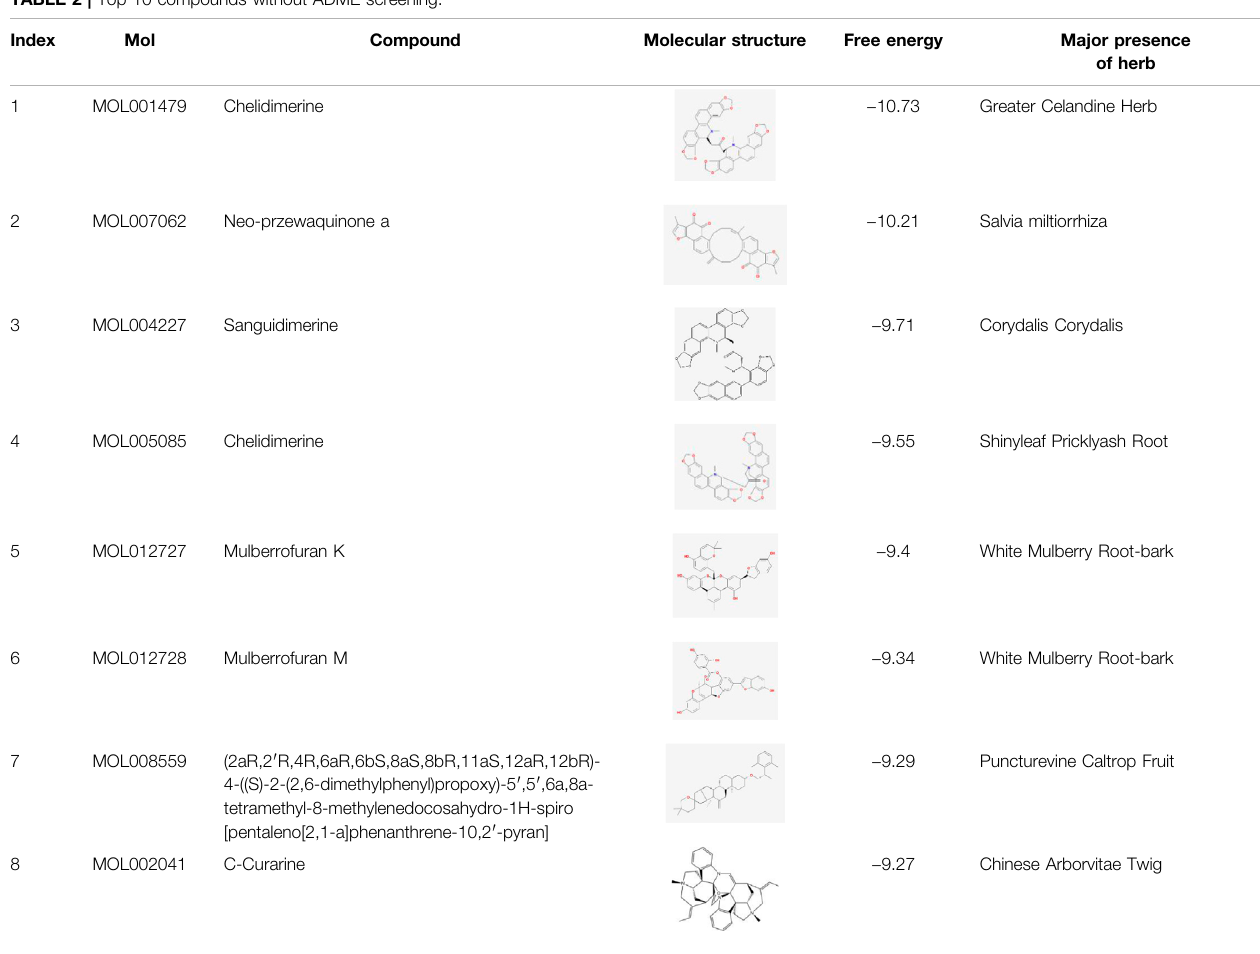
TABLE 2 | Top 10 compounds without ADME